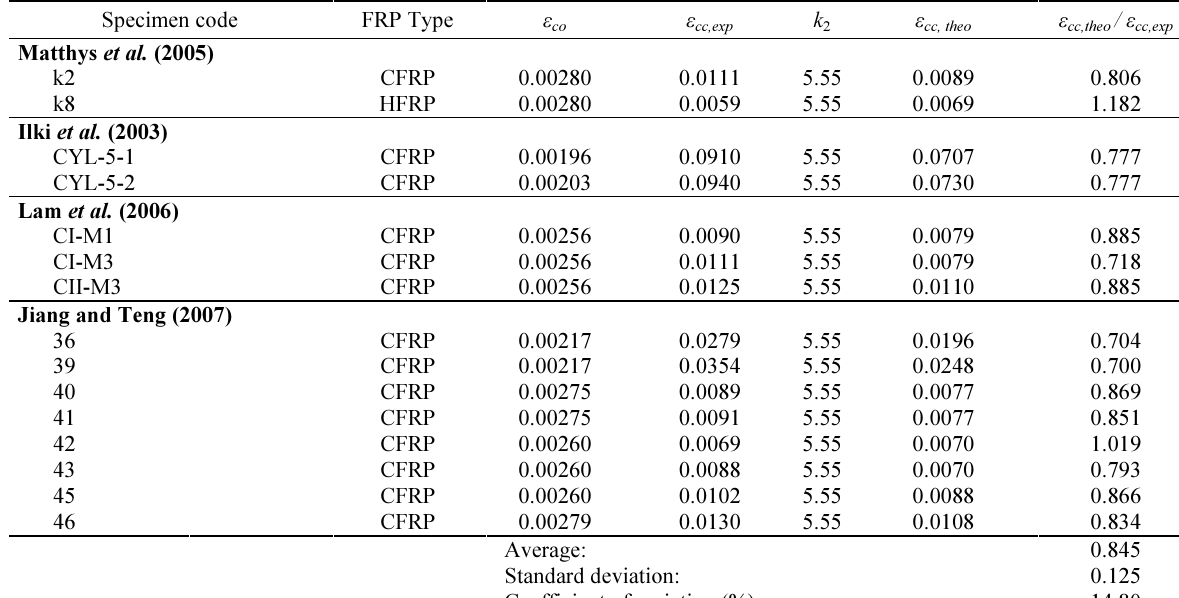
Table 7. Comparison of experimental and predicted results: axial strain Specimen